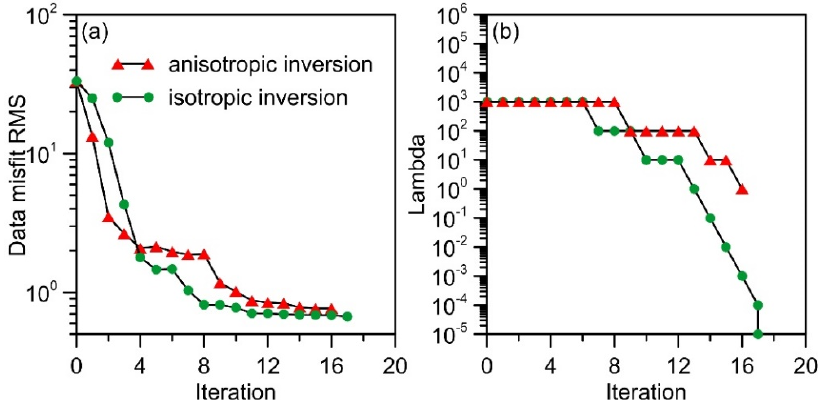
Figure 9. Data fitting and RMS for profile in Figure 3b for the synthetic example 2. ( a ) Anisotropic inversion; ( b ) isotropic inversion. The black lines are for the inversion data, while the red and green lines are for predicted data.